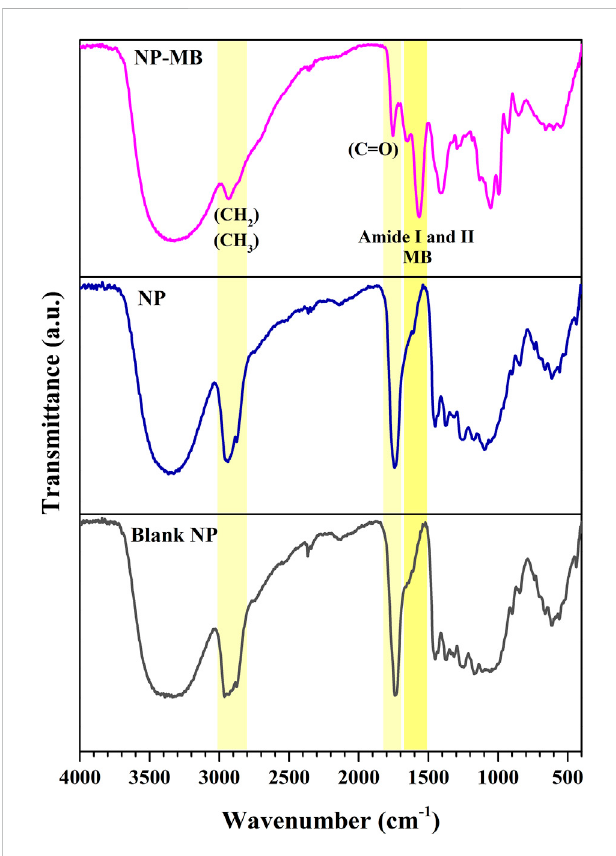
FIGURE 6 FTIR spectra of Blank NP, NP and optimized